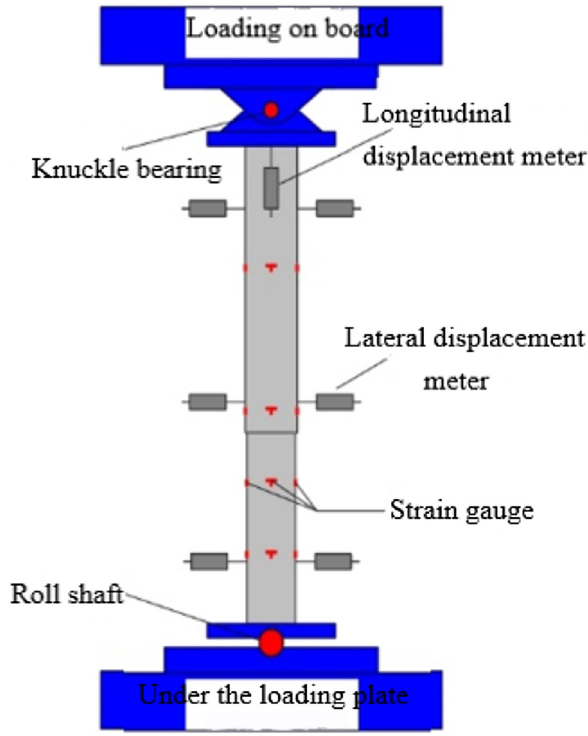
Fig. 6 Schematic of test